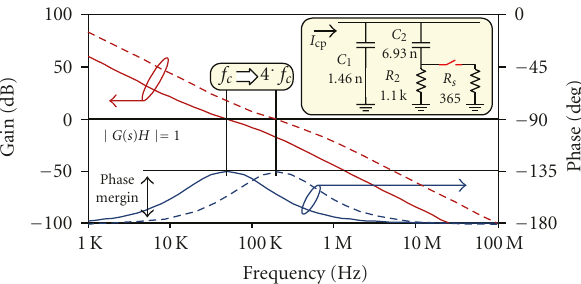
Figure 9: Open loop gain for both PLL loop filter